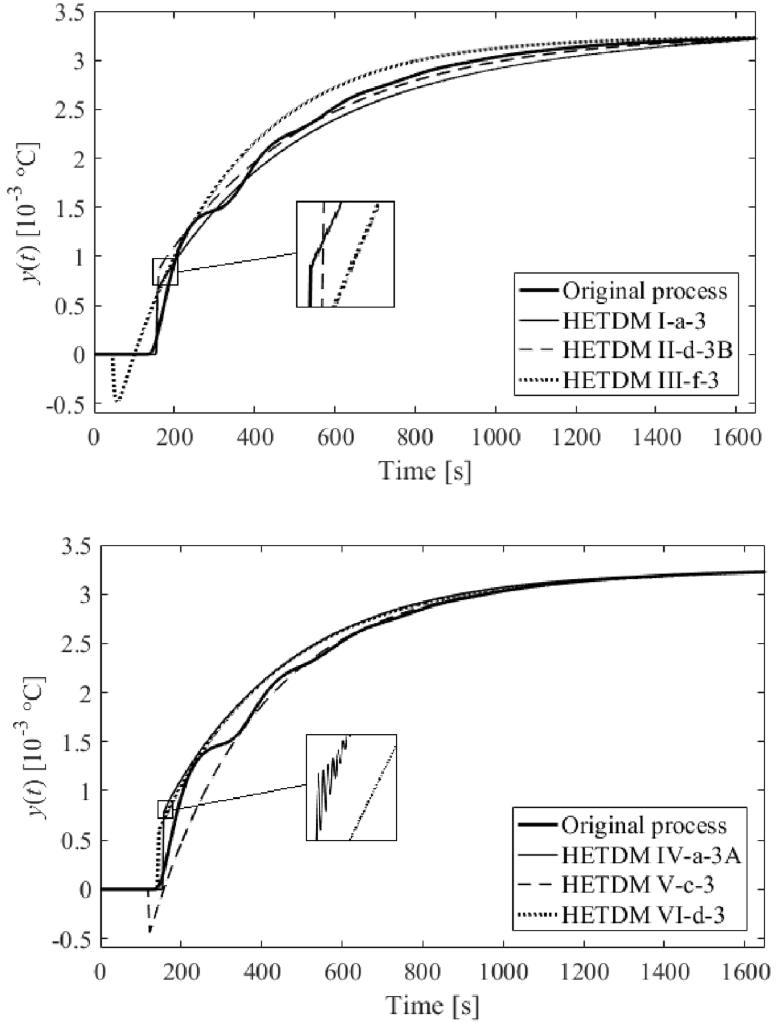
Figure 17. Comparison of selected HETDM unit step responses (vs. the original process response)—NM method used for complete transfer function parameters